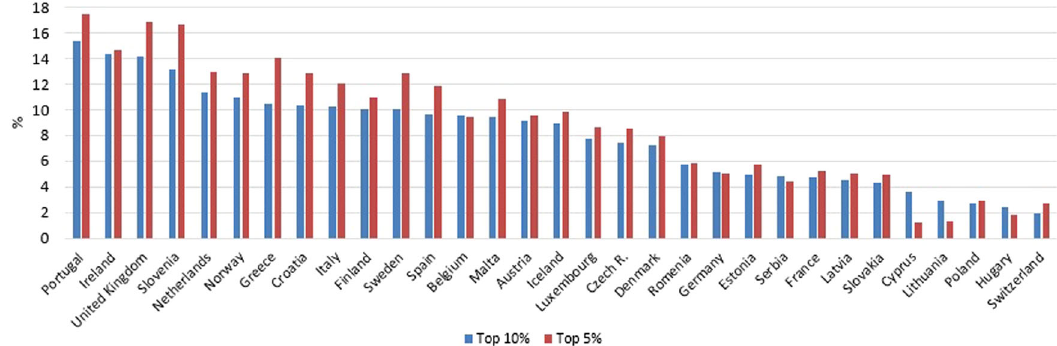
Fig. 2 Redistributive impact of taxes in top 10% and 5% income shares, European countries (2013 – 2014) (%). Source: EU-SILC microdata 2014 and 2015.